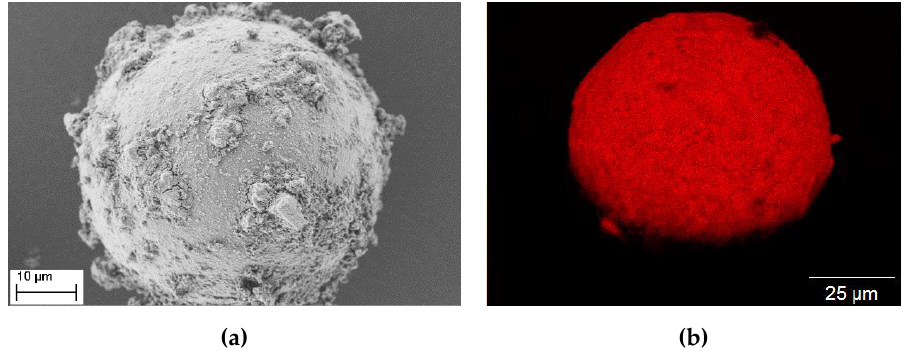
Figure 6 . ( a ): SEM image of Type S coated via LPD-process in a rotating flask (Experiment 2 A). A complete aluminum coating with bigger agglomerates was achieved; and ( b ): EDX-Mapping of a coated sphere Type S (Experiment 2 A). A homogenous aluminum coating (red) could be proven on the surface of the